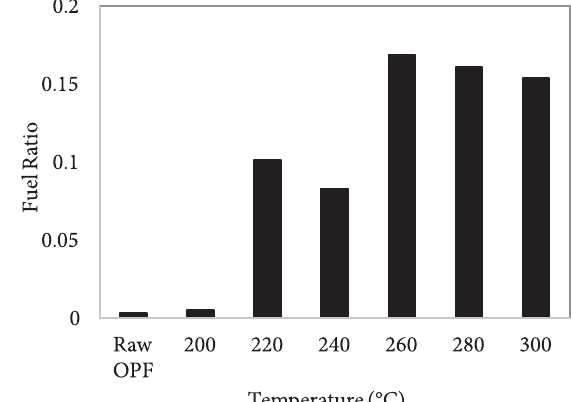
Figure 7. Fuel ratio of